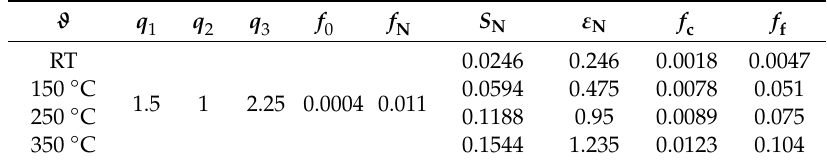
Table 2. Compilation of the determined parameters for the GTN model depending on the temperature for AZ31 thin